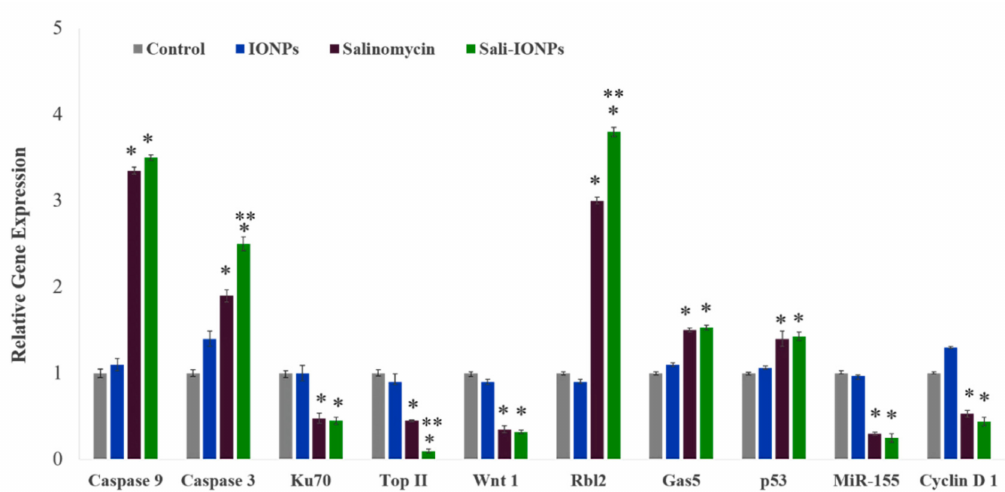
Figure 10. Relative gene expression of U251 cell treated with either IONPs, salinomycin, or Sali-IONPs after 48 h of the treatment. Note: * and ** indicate a significant di ff erence compared to the control and salinomycin groups, respectively, at p < 0.05. Data was presented as mean ± SD; n =